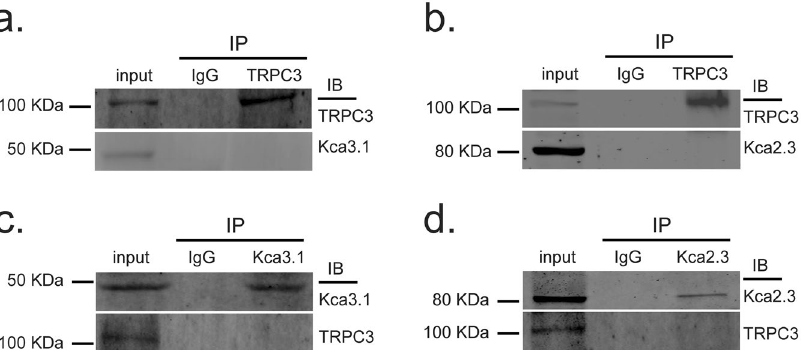
Figure 2. TRPC3 channels do not physically interact with IK Ca and SK Ca channels in PCAECs. The cell lysates were incubated with anti-TRPC3 antibody, and the immunoprecipitates were subjected to immunoblot by anti-K Ca 3.1 and anti-K Ca 2.3 antibodies respectively ( a and b ). The immunoprecipitation and immunoblot experiments were further performed in reversed order ( c and d ). Lysate supernatant (20 μ g of protein) was used as input control. Mouse IgG was used as a negative control. Full-length western blot images are presented in Supplementary Figure S2. Experiments in each order were performed for four times with using cell isolates from different